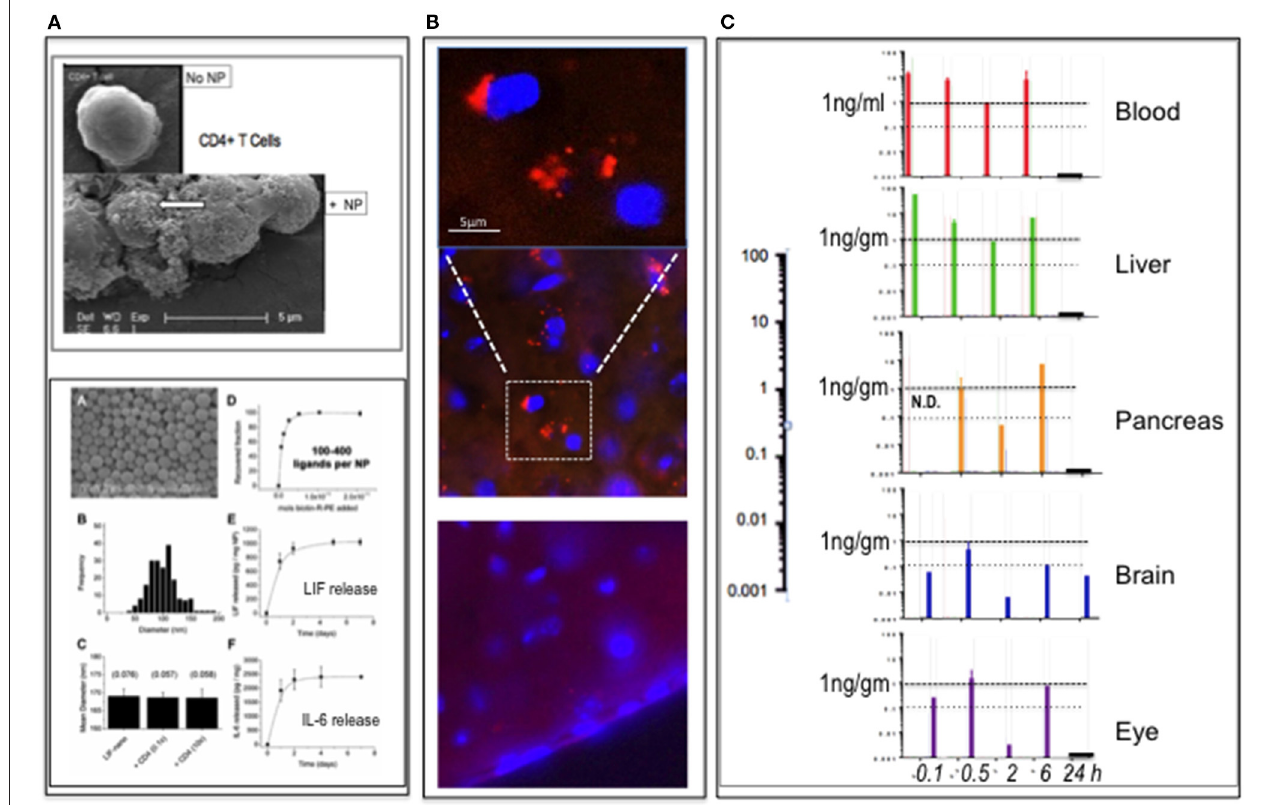
FIGURE 1 | PLGA-nanoparticles targeted to CD4. (A) Top panel: PLGA nanoparticle (NP) targeted to CD4 binding to CD4 + T cells (arrow). (SEM) Bottom panel: modified from Park et al. (1), showing PLGA nanoparticles (A); size distribution (B); constant diameter of functionalized particles (C); number anti-CD4 ligands per particle (D); release rate LIF cargo (E); and release rate IL-6 cargo (F). Full details in Park et al. (1). (B) Detection of rhodamine B (rhoB) cargo in PLGA-CD4 NP in brain parenchyma 6h following i.v. delivery to mouse tail vein using IHC. The upper panel is magnified and image enhanced to reduce the background compared to the middle panel of the 6-h time-point. At 24h (lower panel), there was no definitive evidence of rhoB using IHC. (C) pK and pD of RhoB-PLGA-CD4. Detection of rhoB cargo using HPLC-FD fluorescence quantification of blood, liver, pancreas, brain, and eye (retina) tissues at 0.1, 0.5, 2, 6, and 24h. The 0.1-h sample of the pancreas was not done. Abscissa values are log-scale (expanded on left): a horizontal line marking the 1-ng/gm per tissue is provided for ease of